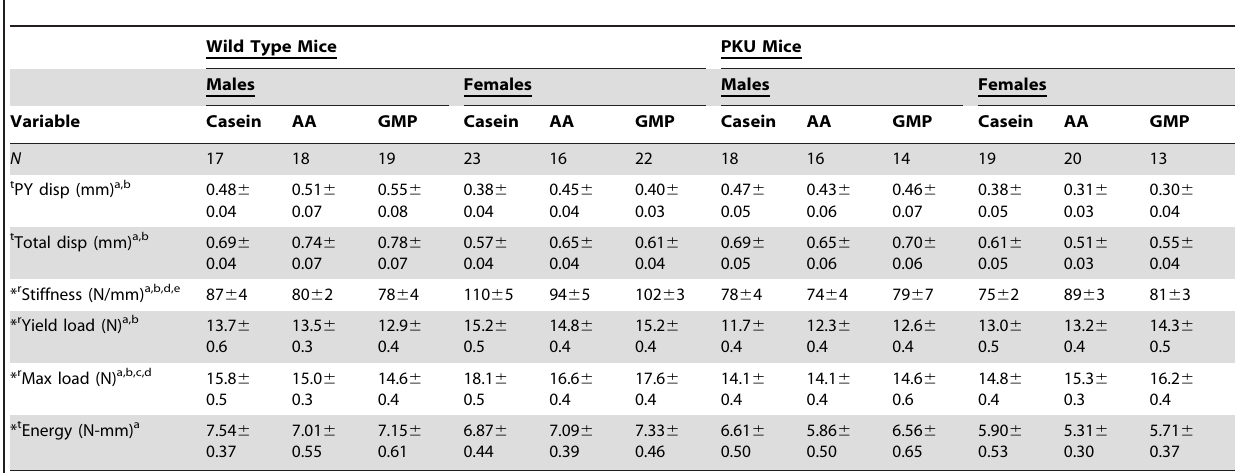
Table 2. Force-displacement curve analysis showing whole bone biomechanical